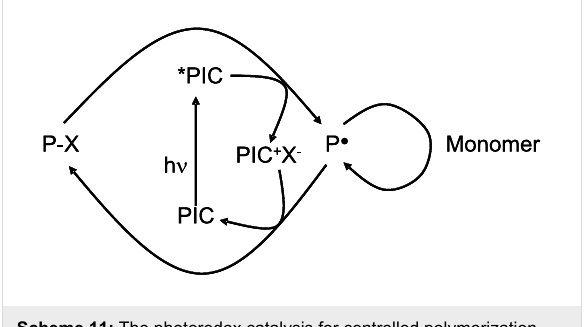
Scheme 11: The photoredox catalysis for controlled polymerization